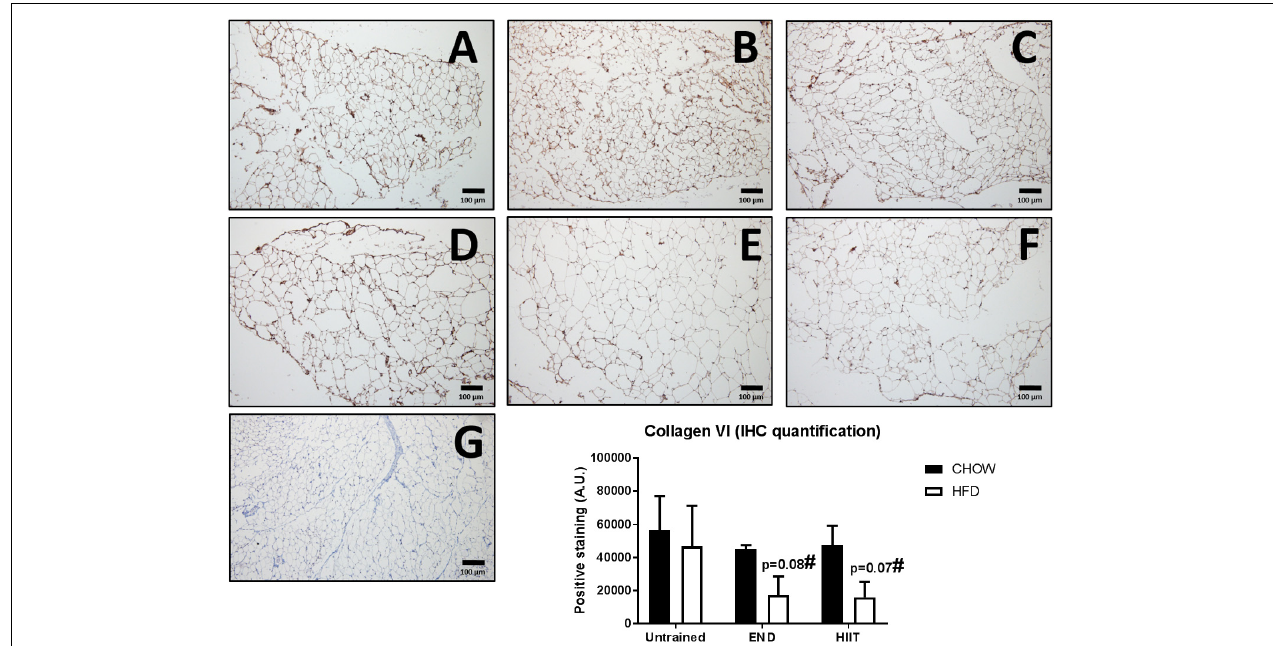
FIGURE 7 | Immunohistochemistry and quantification of subcutaneous adipose tissue collagen VI. Representative cross-sections of subcutaneous adipose tissue with uncoupling protein 1 immunohistochemistry determined by immunoperoxidase stain, and nuclear counter-staining with haematoxylin. CHOW untrained (A) , CHOW+END (B) , CHOW+HIIT (C) , HFD untrained (D) , HFD+END (E) , and HFD+HIIT (F) are displayed. In HFD animals, both exercise programs showed a trend to induce a reduction of this protein. A negative control without primary antibody is shown in (G) . The size bars indicate 100 µ m and images are at 10 × magnification. Quantification of positive staining is presented as means ± SEM and the number of animals in each group is 3. # p = 0.07 and 0.08 vs. HFD untrained by Two-way ANOVA with Tukey’s and Sidak’s post hoc